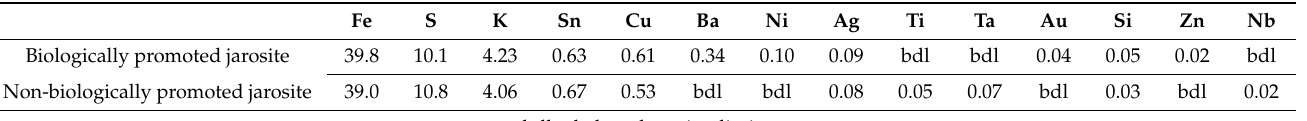
Table 3. Elemental composition (wt%) of jarosite samples recovered from the two-step leaching experiments. Fe S K Fe Biologically promoted jarosite Non-biologically promoted jarosite